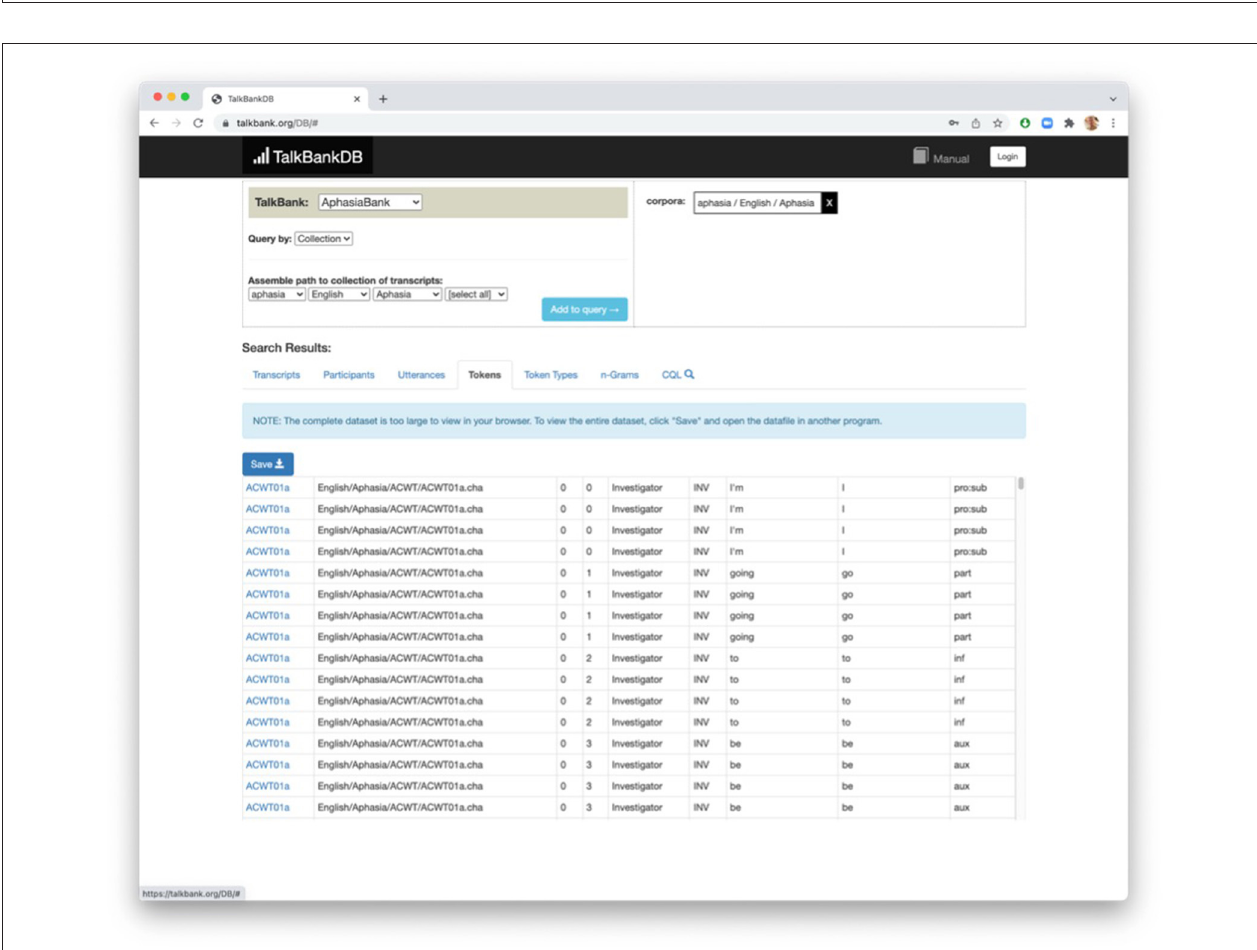
FIGURE 9 | A TalkBankDB search for tokens from English-speaking